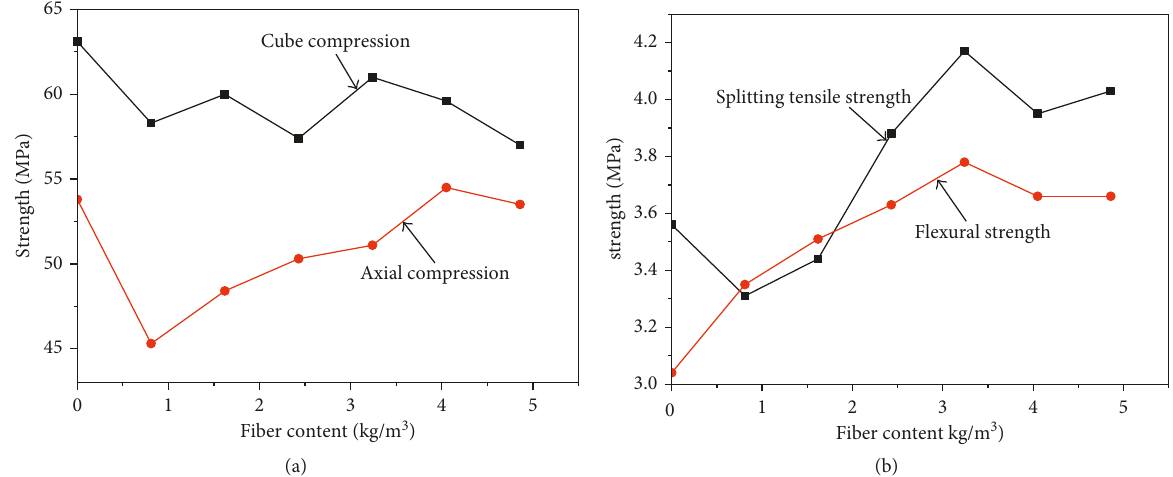
Figure 5: The effects of fiber content on (a) the cubic and axial compressive strengths and (b) the splitting tensile and flexural strengths of BFRSCC [48].